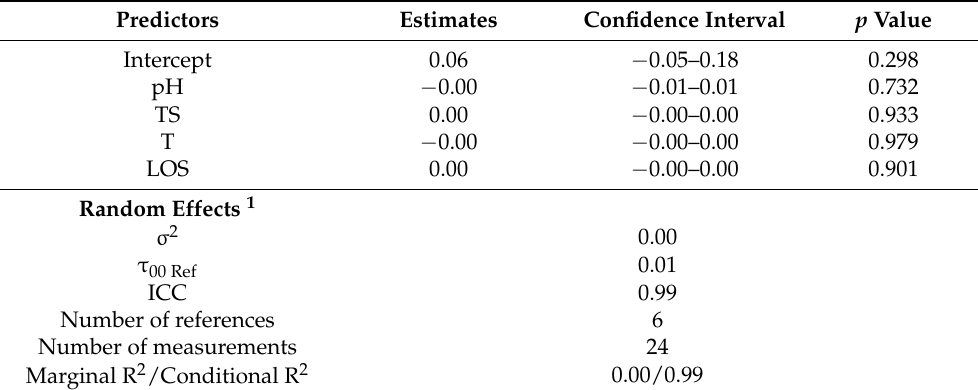
Table 5. Parameter estimates of linear mixed effects model for N 2 O–N emissions from slurry